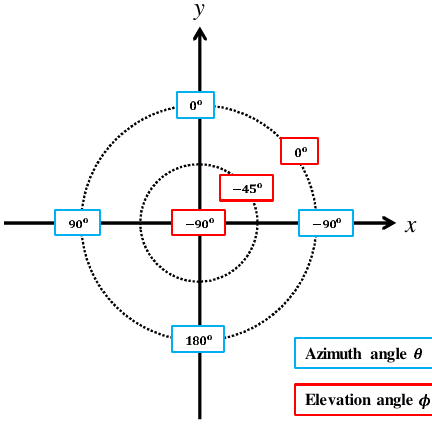
Figure 6. Previous visualization tool based on Google Earth TM .